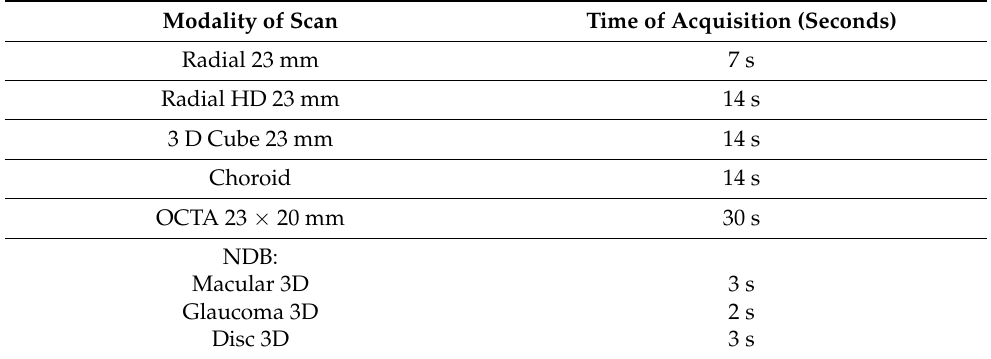
Table 3. Time of wide-field imaging acquisition in cooperative patients and those with good visual